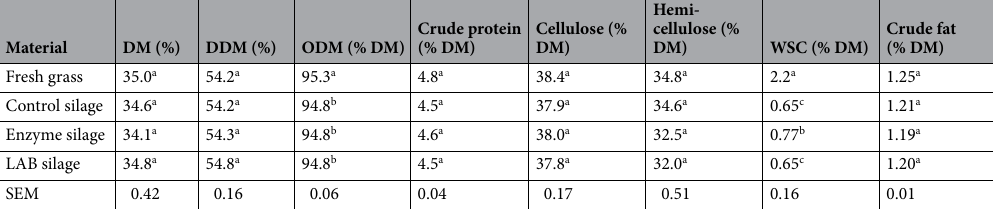
Table 2. Chemical composition of fresh and ensiled Spartina pectinata L. LAB Lactobacillus buchneri M B/00077, SEM standard error of the mean. a,b Mean values (in columns) marked with different letters differ significantly, α = 0.05.